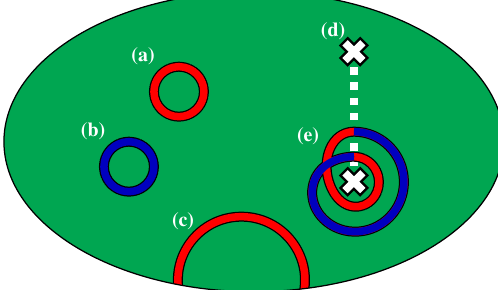
FIG. 4. A schematic diagram of the planar-code lattice with a rough boundary. Strings of Pauli- Z (Pauli- X ) operators are marked by red (blue) lines, respectively. Diagrams (a) and (b), respectively, show A f and B f stabilizer operators. (c) An element of the stabilizer group where a string of Pauli- Z operators follows a trivial path and terminates at the same rough boundary of the lattice. (d) A defect line marked by a dashed white line with two twist defects at its end points. Red strings that cross the defect line change to blue and vice versa. (e) A stabilizer operator that encloses a single twist. The string must wind twice around the twist, which changes the string from red to blue and back to red again to form a closed loop. As mentioned, the stabilizer should also include a complex phase due to the point where the two strings cross, which we do not consider